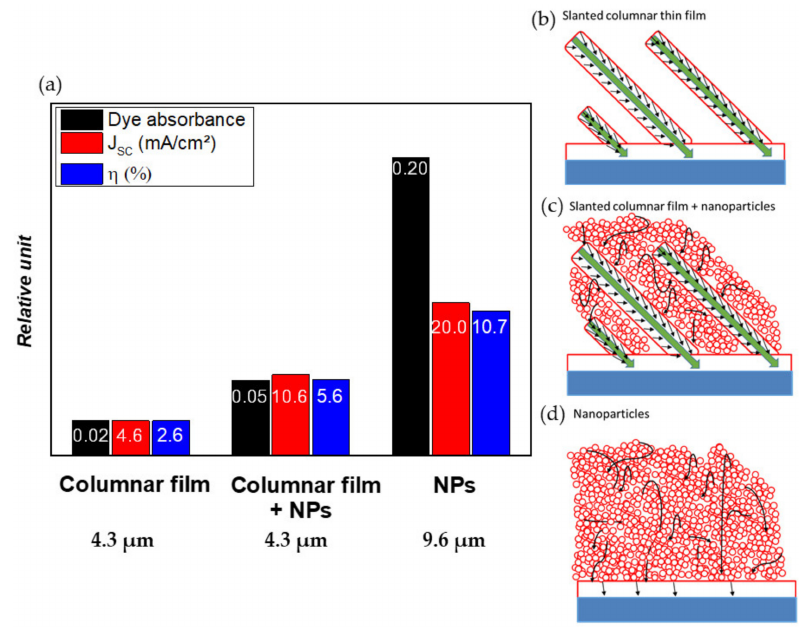
Figure 21. ( a ) Photovoltaic performances of DSSCs based on various photo-anode architectures. Schematic representation of the electron transfer occurring in photo-anode based on: ( b ) Slanted columnar thin film; ( c ) the combination of slanted columns and nanoparticles; ( d ) nanoparticulate thin